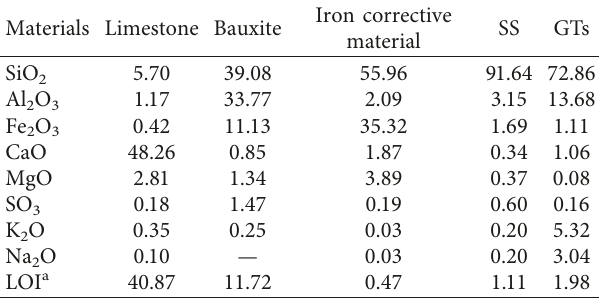
Table 1: Chemical compositions of raw materials (wt.%).